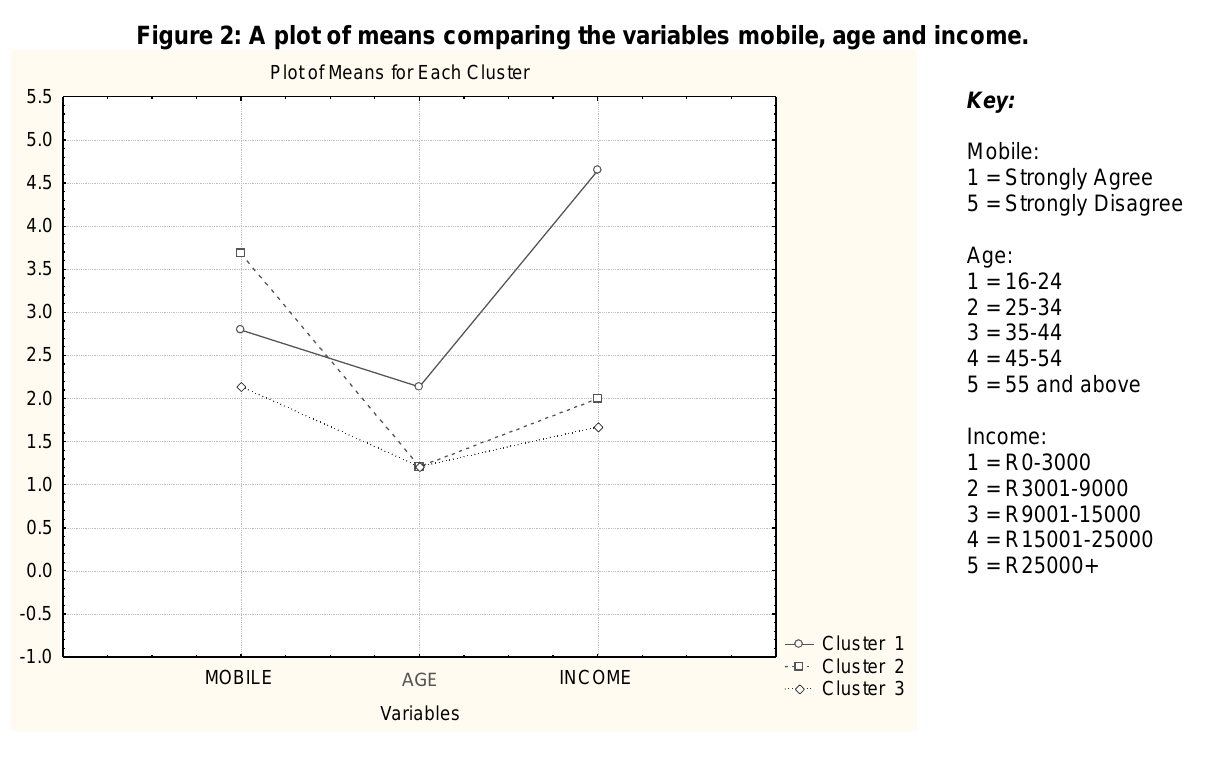
Cluster 1 Cluster